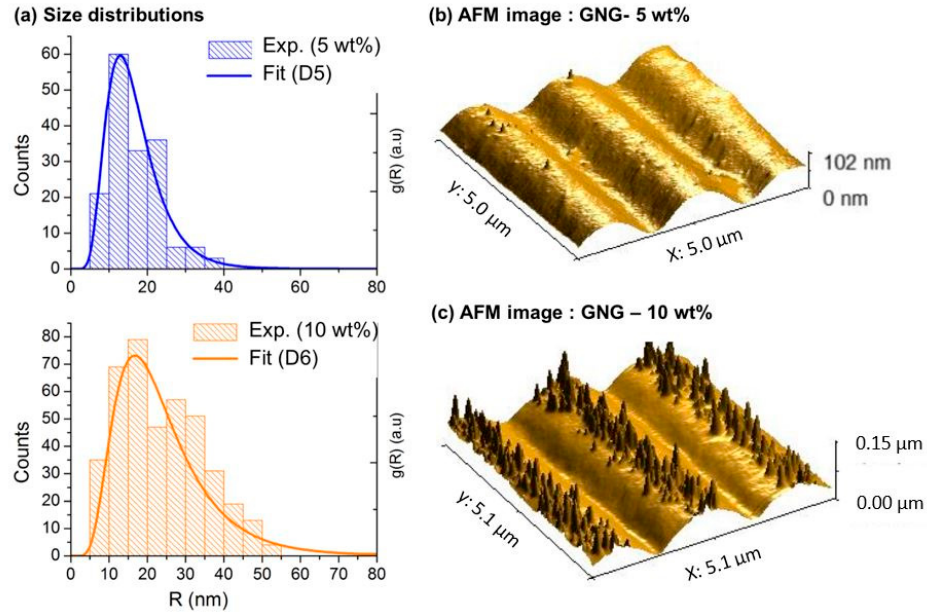
Figure 6. ( a ) Histograms and fitted size distributions of the GNGs at 5 wt % and 10 wt %; ( b ) 3D view of typical AFM images of these samples.